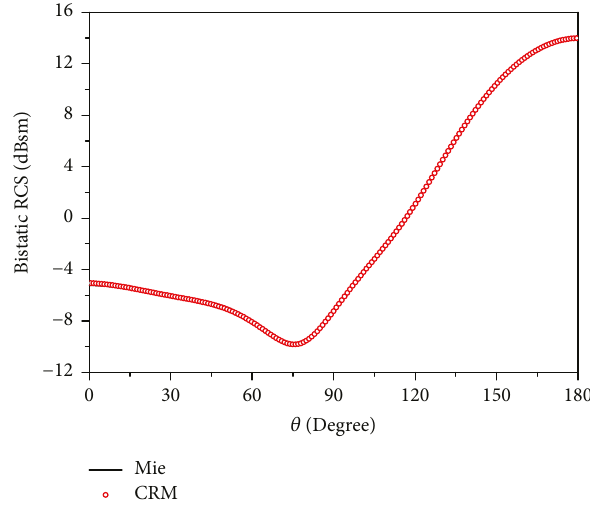
Figure 9: The bistatic RCS of a dielectric sphere at 300 MHz, HH